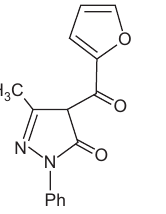
Figure 1 The structure of HPM α FP.